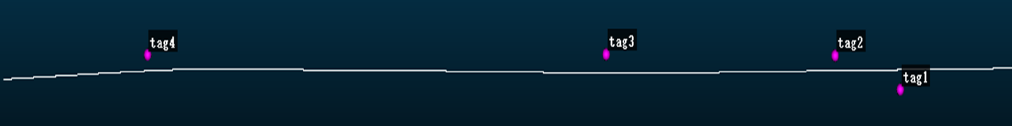
Figure 21. Comparison of trajectory error before and after filter correction. As shown in Table 4, the trajectory deviation before filter correction gradually in- creased with the distance. After filtering and correction, the maximum lateral deviation was 0.0482 m, the average deviation was 0.0239 m, the vertical maximum deviation was 0.0405 m, and the average deviation was 0.0138 m. Table 4. Comparison of trajectory deviation between before and after filter correction and integrated navigation. Mileage Location(m) Deviation before Filtering Correction